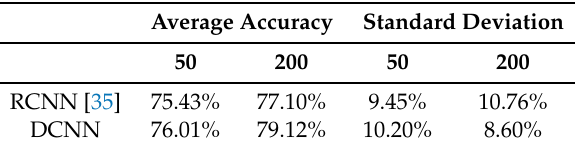
Table 11. Average accuracy scores and their standard deviation of the 10-fold cross-validation of the Actitracker dataset.